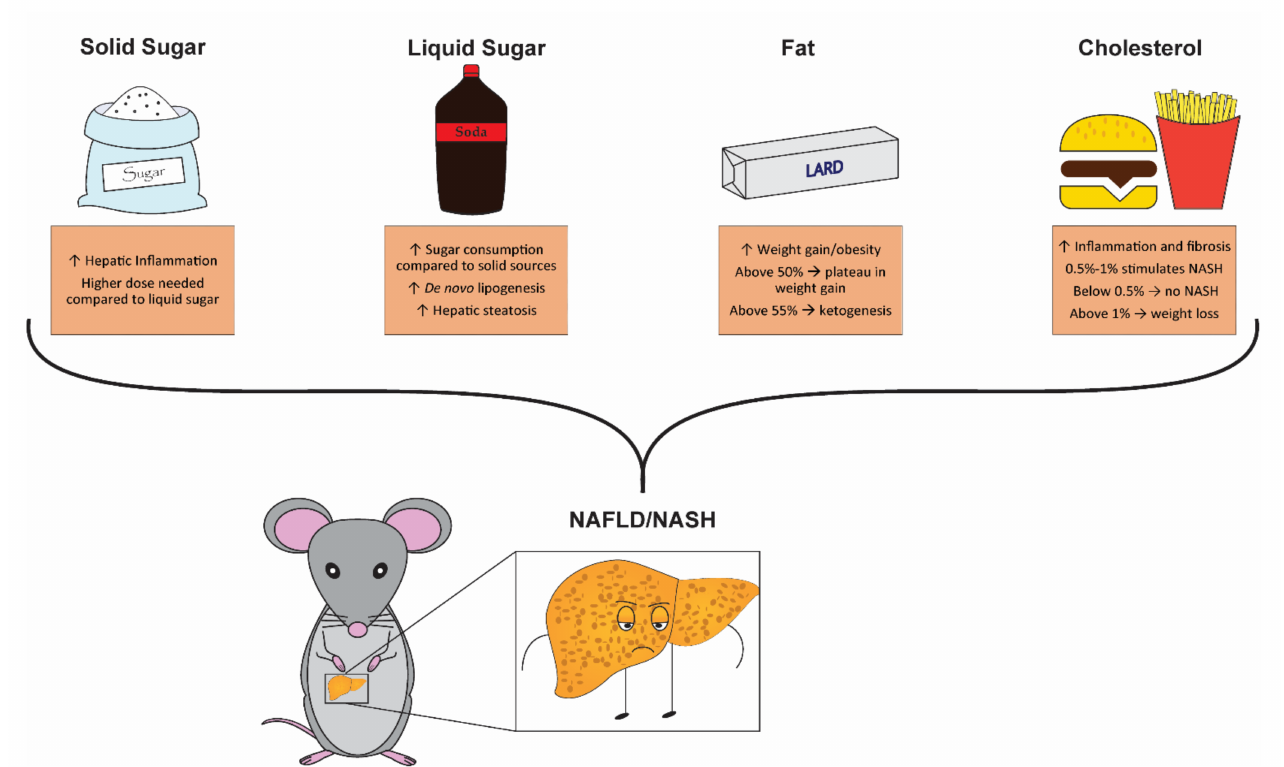
Figure 2. Summary of key dietary components contributions when modeling non-alcoholic fatty liver disease (NAFLD) and non-alcoholic steatohepatitis (NASH) in rodents. Inclusion of solid sugar stimulates hepatic inflammation compared to liquid sugar, whereas liquid sugar contributes more to hepatic lipid accumulation. Using solid sugars requires higher dosage to induce liver damage compared to liquid sources. High fat is required to stimulate obesity; however, at quantities above 50% kcal there is a plateau in weight gain. Inclusion of cholesterol promotes hepatic inflammation and fibrosis. Evidence suggests that the optimal dosage of cholesterol for mice is between 0.5% and 1%, but may vary between mouse strains. Below 0.5%, diets fail to induce inflammation and NASH, while above 1% prevents weight